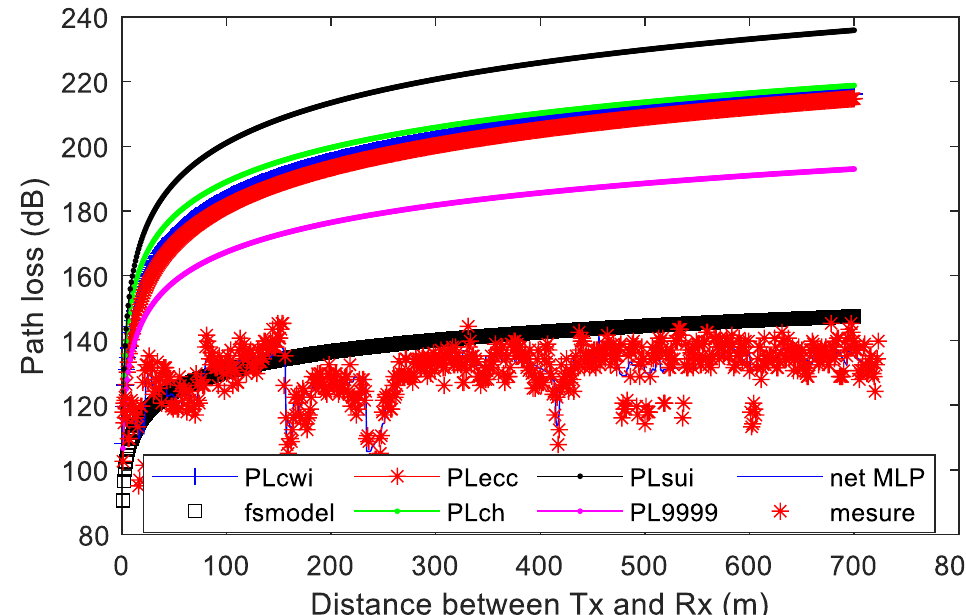
Figure 10. Comparison between empirical models and MLP (with one hidden layer) for Dataset 1.